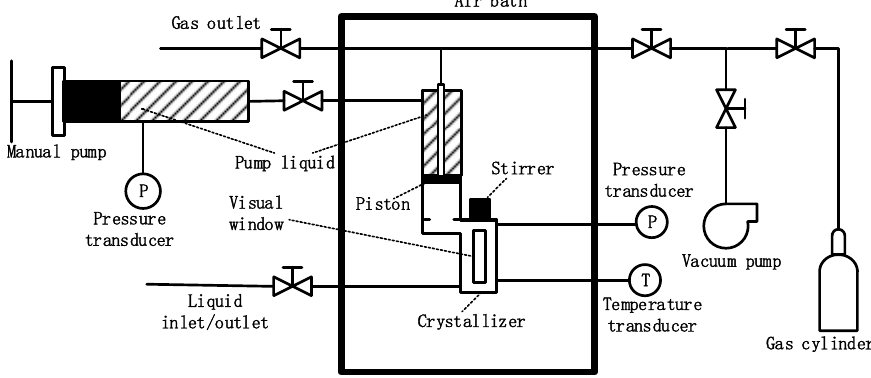
Figure 1. The experimental apparatus for the experiments in Sections 2.2 and 2.4.